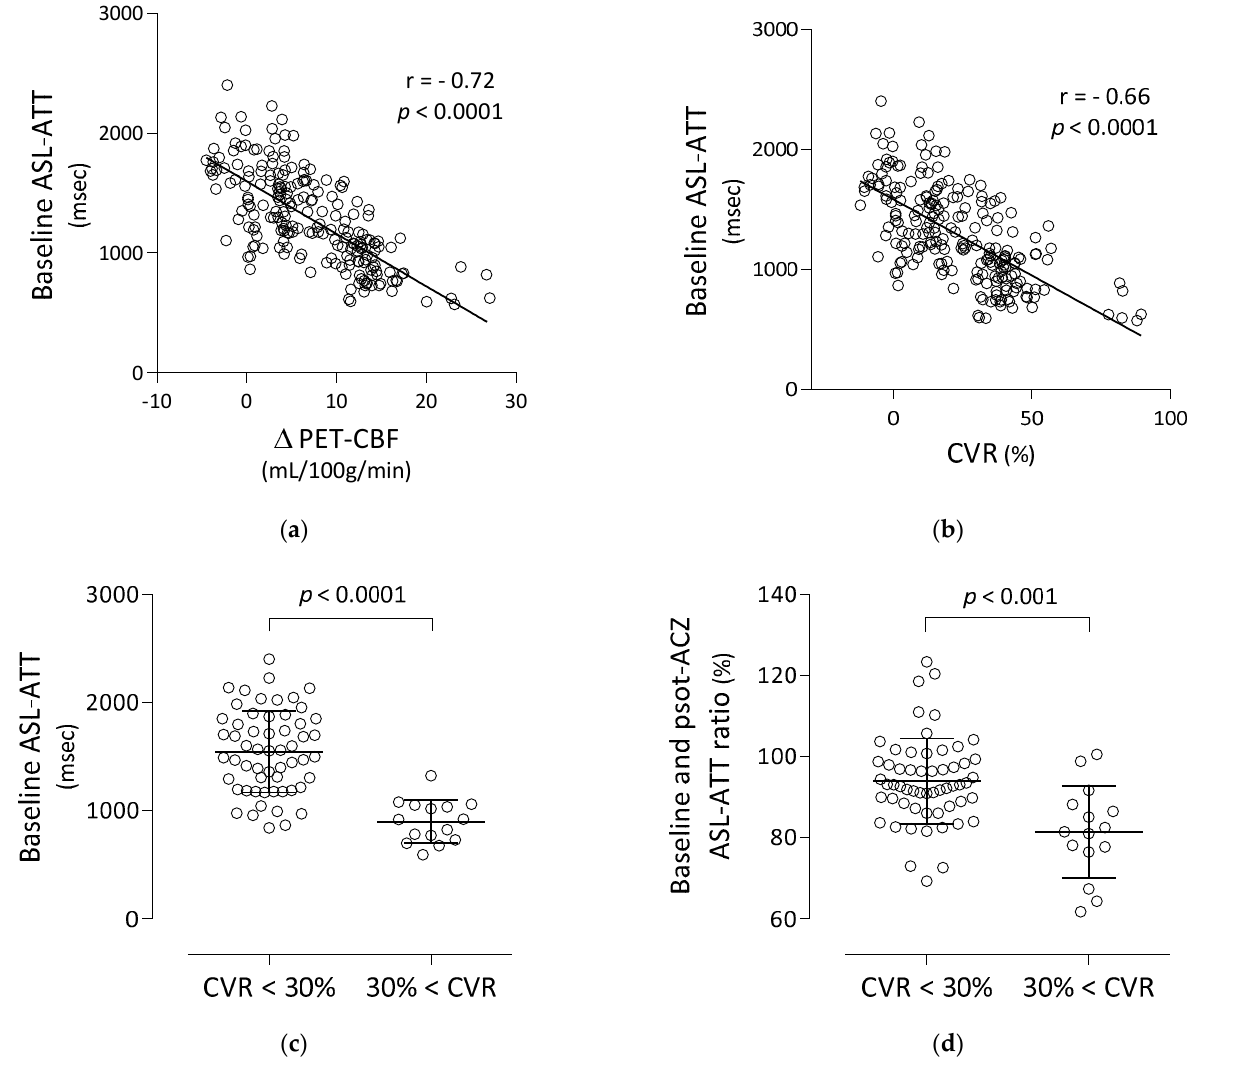
Figure 4. Correlation between pre-ACZ ASL-ATT and ∆ PET-CBF ( a ) and CVR ( b ). Regression lines are shown with Pearson’s correlation coefficients (r) and associated p -values. Group comparisons of ASL-ATTs ( c ) and the ratio ( d ) between ROIs with and without CVR of MCA territory less than 30%. The significance of differences was assessed by unpaired t test.